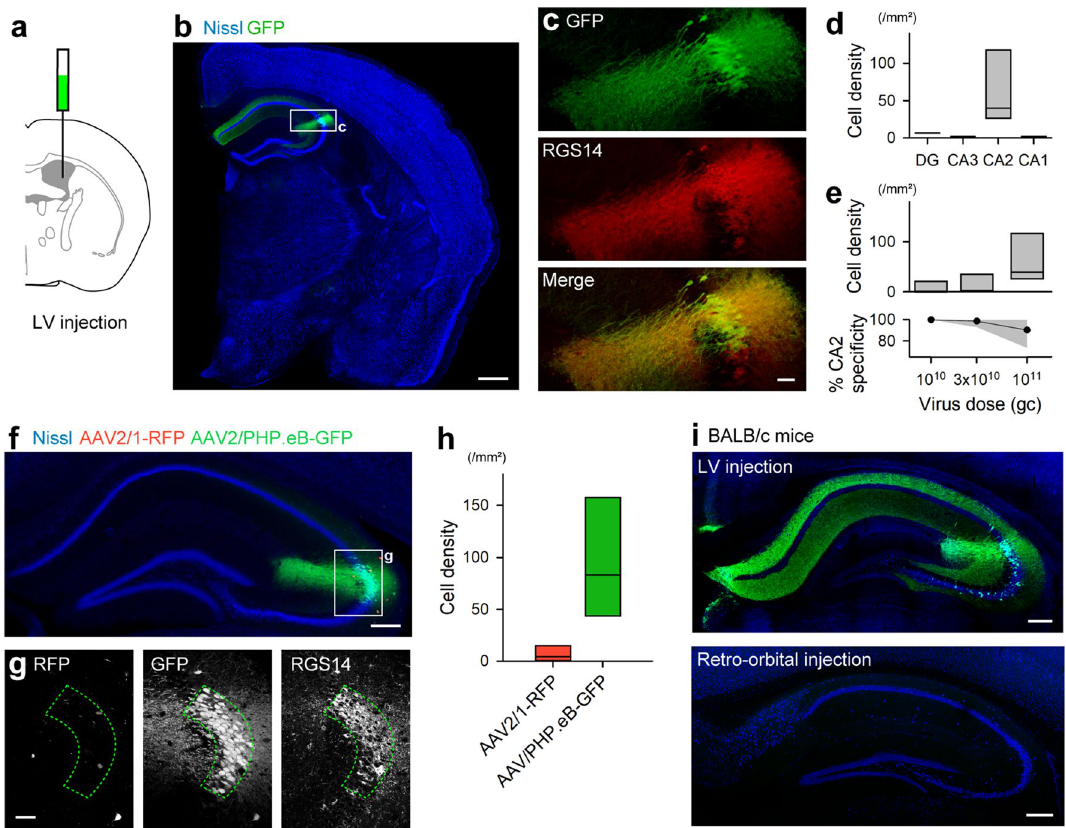
Figure 2. Restricted infection of CA2 pyramidal cells via injection into the LV. ( a ) A schematic view of LV injection. ( b ) GFP expression after LV injection of the AAV2/PHP.eB-SynTetOff-GFP vector. Scale bar, 500 μm. ( c ) Enlarged view of the CA2 region in ( b ). Scale bar, 50 μm. ( d ) Density of GFP-expressing cells in the hippocampal subregions. The lines and rectangle indicate the means and distributions of 25% and 75%, respectively ( n = 5 sections from 5 mice, H = 13.7, df = 3, P = 3.4 × 10 −3 , Kruskal–Wallis test). ( e ) (Top) Virus dose-dependent increase in the infected cell density in the CA2. The rectangles indicate the means and distributions of 25% and 75% ( n = 4–6 sections from 4 to 6 mice). (Bottom) Specificity for infection of CA2 pyramidal cells. Gray area indicates 95% confidence interval ( n = 4–6 sections from 4 to 6 mice, F = 4.36, df = 2, P = 0.038, one-way analysis of variance (ANOVA)). ( f ) LV injection of AAV2/1-SynTetOff-mRFP1 and AAV2/ PHP.eB-SynTetOff-EGFP. Scale bar, 200 μm. ( g ) Enlarged view of the CA2 area in ( f ). Scale bar, 50 μm. ( h ) Cell density of RFP- or GFPexpressing cells in the CA2 area. The rectangles indicate the means and distributions of 25% and 75% ( n = 4 sections from 4 mice, t = 2.78, df = 6, P = 0.032, two-tailed unpaired Student’s t -test). ( i ) LV (top) or retro-orbital (bottom) injection of AAV2/PHP.eB-SynTetOff-EGFP in BALB/c mice. Scale bar, 200